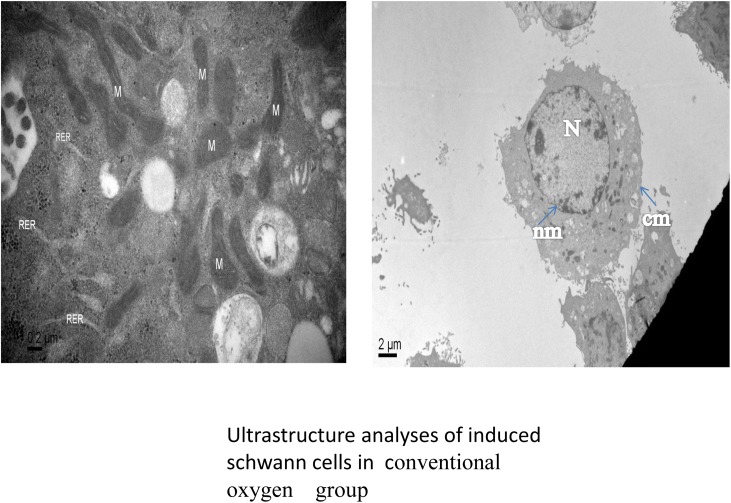
Images from the conventional oxygen group show no cell edema and good cell membrane integrity.Rough endoplasmic reticulum is not dilated, visibly intact mitochondrial membranes, and mitochondria with clear cristae and without swelling and fracturing, the nucleolus is not shrinkage, nuclear membrane integrity. M: mitochondria RER:rough endoplasmic reticulum N:nucleolus, nm: nuclear membrane, cm: cell membrane.